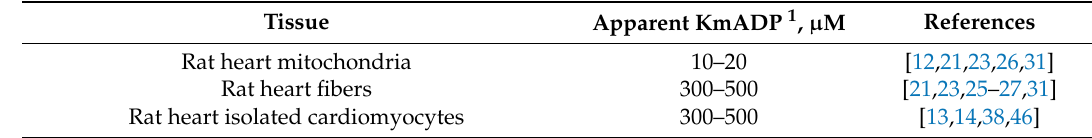
Figure 1. The Mitochondrial Interactosome (MI) and the role of tubulin in its regulation. In the MI of oxidative muscle cells the tubulin C-terminal tail interacts with the mitochondrial voltage-dependent anion channel (VDAC) and restricts the diffusion of adenine nucleotides ATP and ADP through the channel. Tubulin-VDAC interaction does not interfere with creatine (Cr) and phosphocreatine (PCr) movement in or out of the mitochondria. Creatine is phosphorylated in the mitochondrial intermembrane space (IMS) by mitochondrial creatine kinase (MtCK). As the MtCK is located close to the adenine nucleotide translocase (ANT), the ATP produced in the mitochondrial matrix is quickly directed to MtCK reaction and ADP is transported back to the matrix. Due to this VDAC-tubulin interaction the energy-rich phosphate is directed to the CK energy transfer network and MtCK has become an important regulator of the ATP synthasome (consisting of the F o F 1 -ATPase, respiratory chain complexes, inorganic phosphate carrier (PIC) and ANT). Hexokinase (HK) can also bind to VDAC. The main task of this interaction is to guide the ATP produced in mitochondria to be available for glycolysis. In MI of cancer cells MtCK probably does not participate in the regulation of oxidative phosphorylation. To what extent and how tubulin (supposedly β III-tubulin) and HK compete for binding on VDAC needs further investigation. MOM—mitochondrial outer membrane; MIM—mitochondrial inner membrane. Table 1. Apparent KmADP for exogenous ADP in regulation of respiration in permeabilized cells and fibers from different tissues with or without creatine or trypsin treatment.